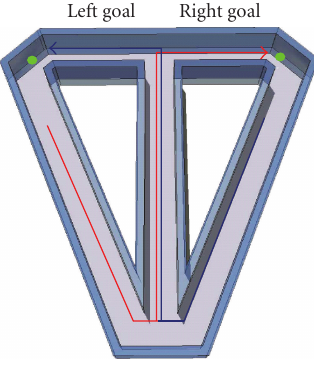
Figure 1: T-maze continuous alternation. Blue line indicates left- turn trial; red line indicates right-turn trial. Small green circles represent reward